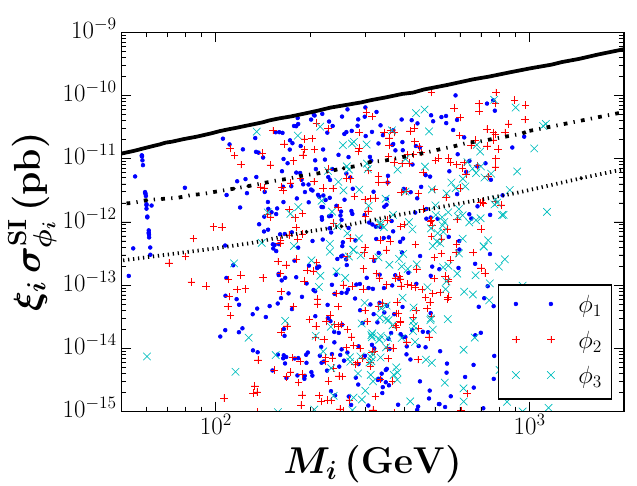
Figure 4 . Detection prospects in the scan with µ S 4 6 = 0 (scan A). The solid line is the current LZ limit whereas the dash-dotted and dotted lines correspond to the expected sensitivities of LZ [66] and DARWIN [68]